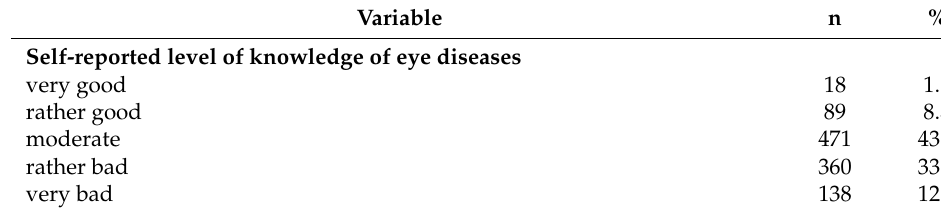
Table 2. Respondents’ knowledge regarding common eye diseases (n =